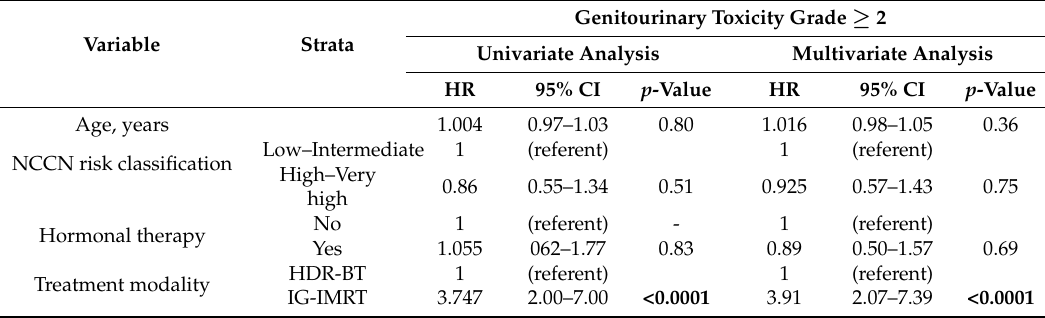
Table 5. Univariate and multivariate analysis for genitourinary toxicity grade 2 or more.